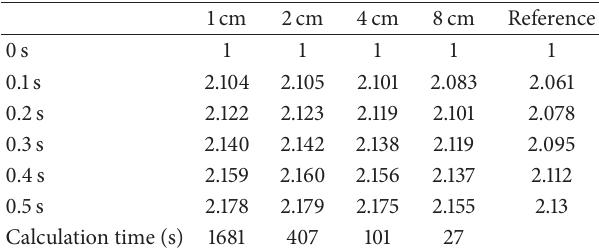
Table 5: Results for different mesh size during step